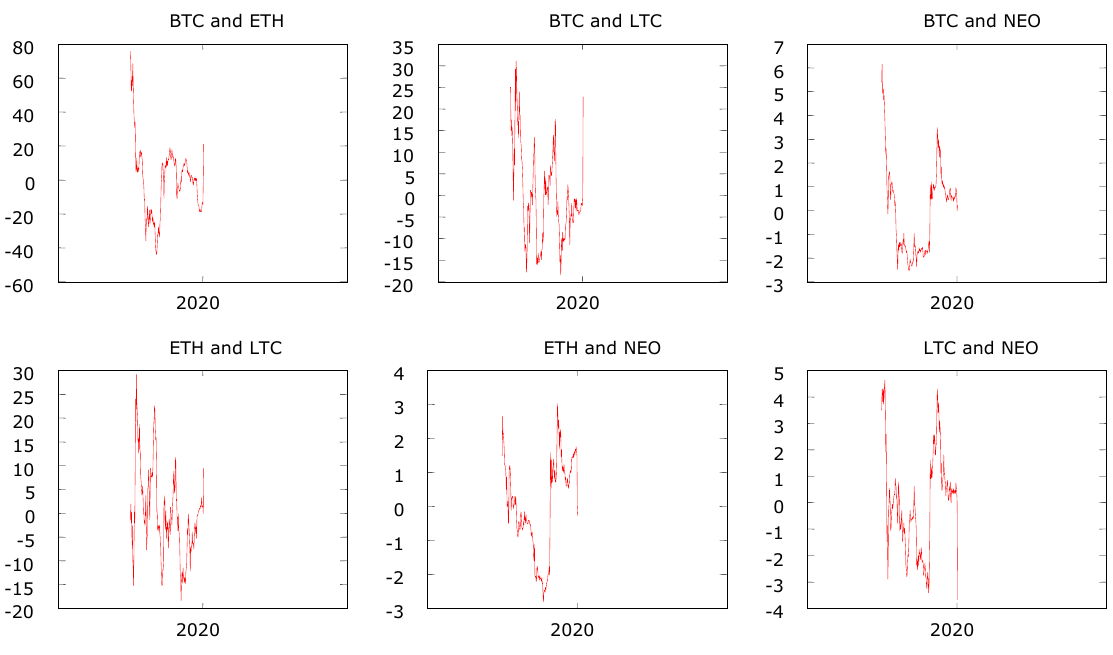
Figure 4. Cointegration residuals in Panel D